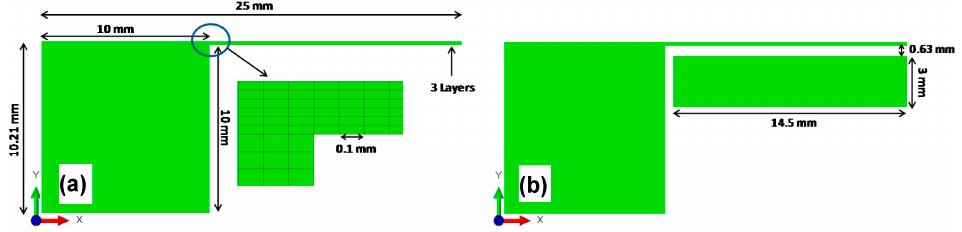
Figure 5. Overhang model geometry used in simulations: ( a ) without and ( b ) with a heat